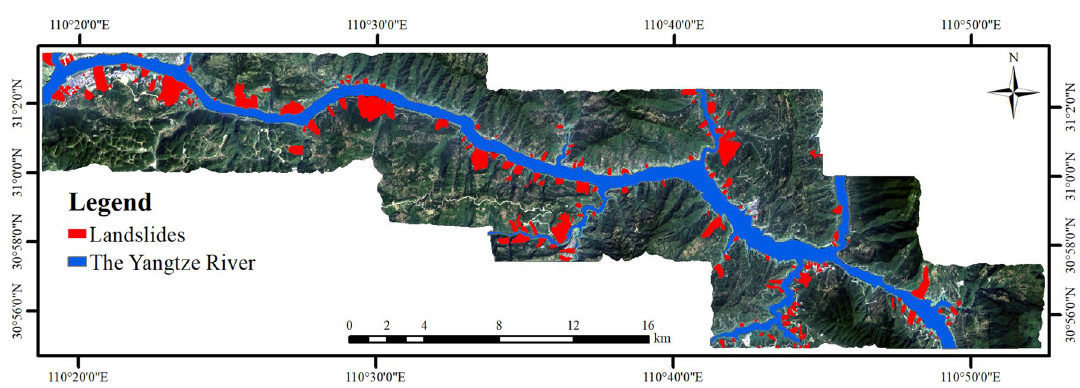
Figure 4. The landslide distribution of the study area (drawn with ArcGIS 10.8 software, and the URL is: https:// www. esri. com/ en- us/ arcgis/ about- arcgis/ overv